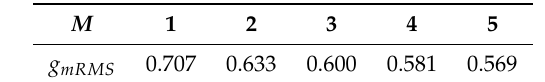
Table 1. RMS Max r E weightings for Ambisonic orders 1 to